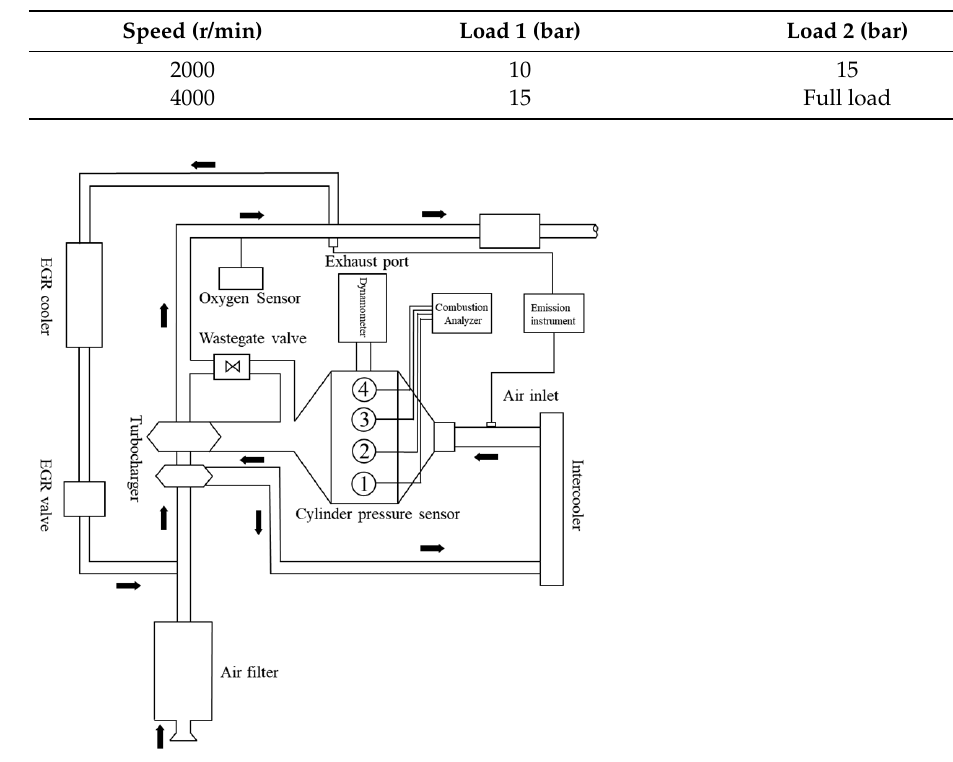
Table 3. Test operating point.